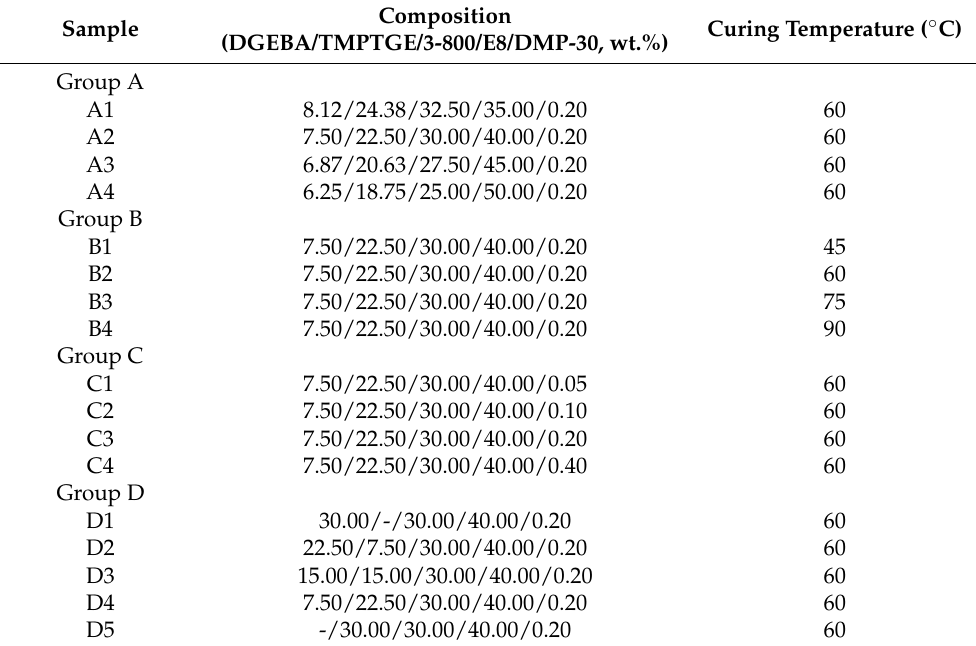
Table 1. The compositions and curing temperature of the samples used in this